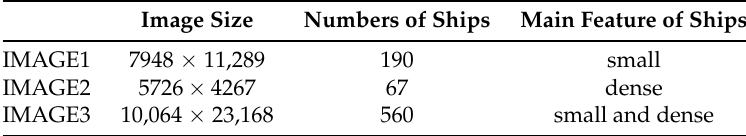
Table 2. The information of the testing